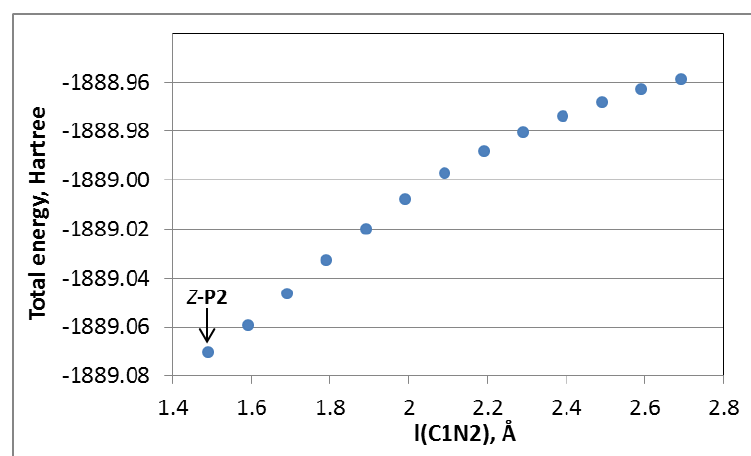
Figure 1. Energy scan for the C(1)N(2) bond cleavage in Z - P2 .